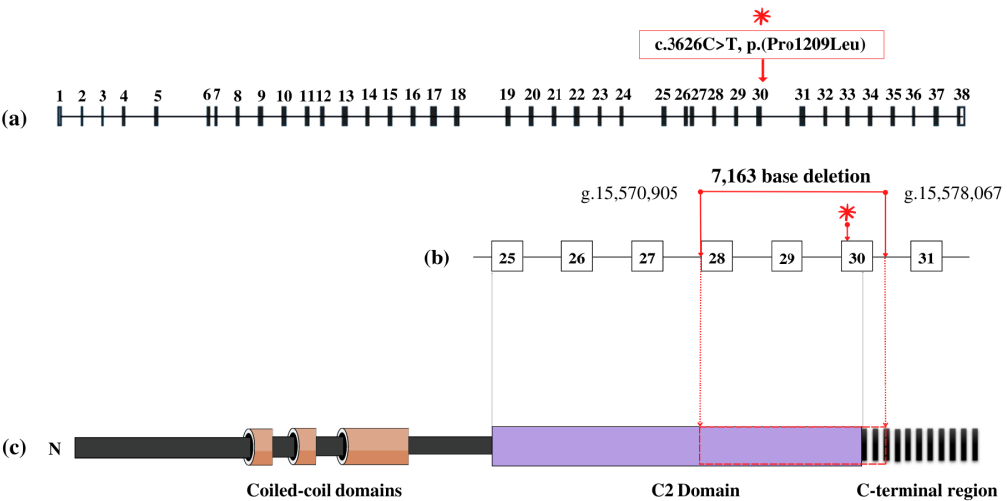
Figure 2. Schematic representation of the localization of the missense variant (shown by *) and 7163 base deletion in the CC2D2A gene and protein domains. ( a ) Exons (black boxes 1–38) and introns; ( b ) the enlarged view shows deletion within the genomic breakpoints, and the position of the missense in exon 30; ( c ) protein domains: coiled-coil domains, C2 domain, and C-terminal region.